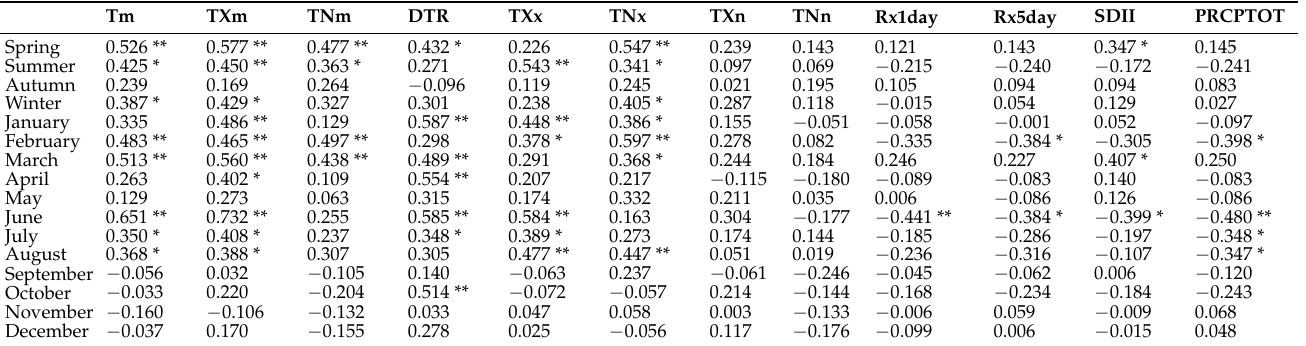
Table 5. Correlation coefficients between the regional mean NDVI and the extreme temperature (precipitation) indices on a seasonal/ monthly scale during